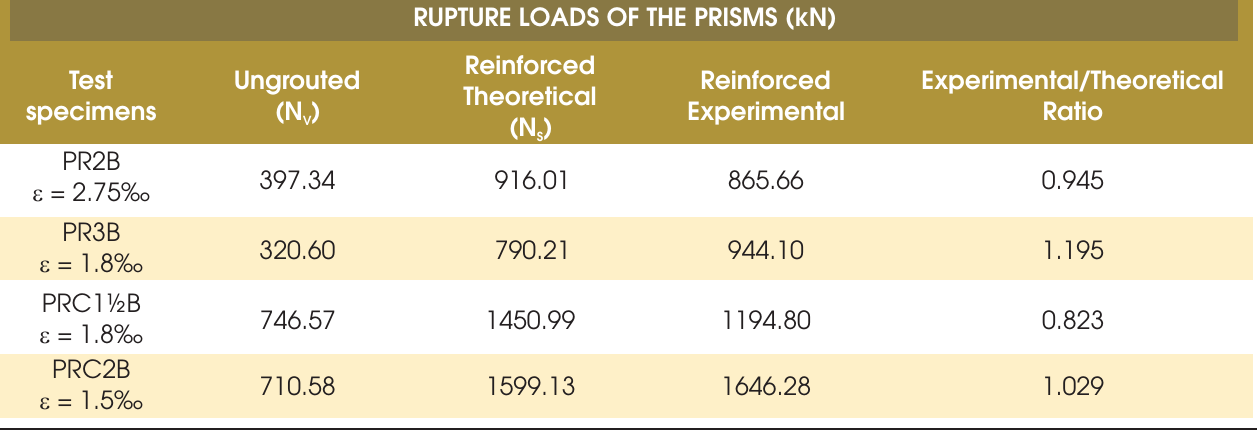
Table 12 – Comparison of mean theoretical vs. experimental loads to break strain (Model III – 1.5‰)